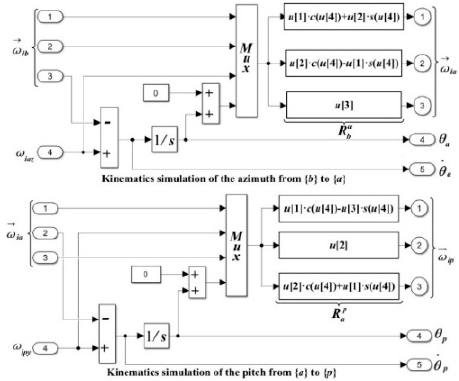
Figure 6. Simulation modules of the System’s General Kinematics and Compensations.